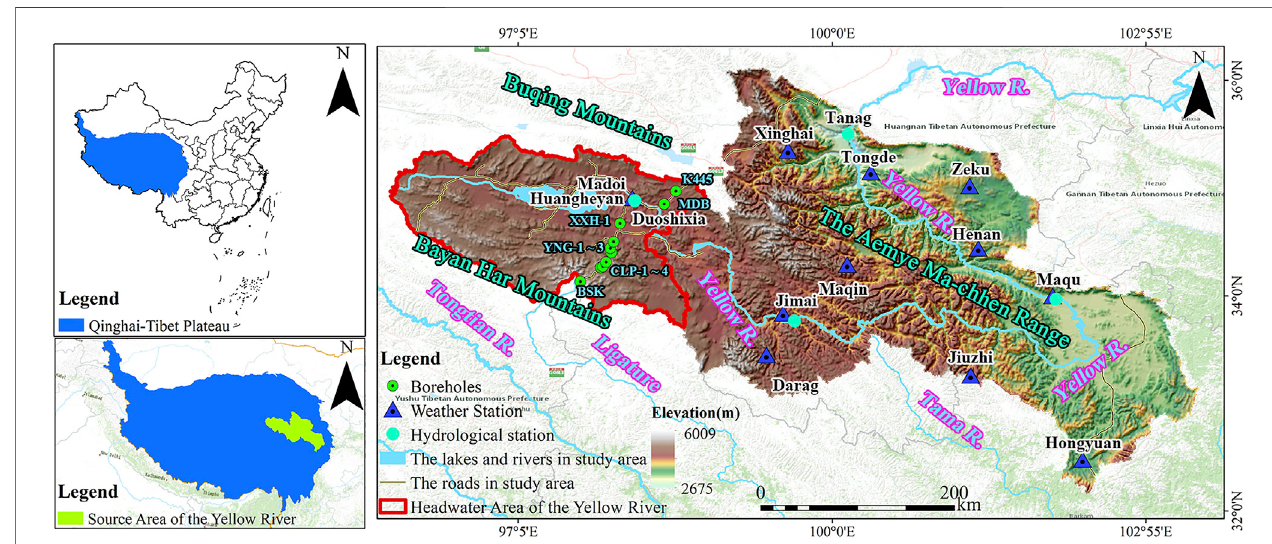
FIGURE 1 | Location, mountains and water systems of the Source Area of the Yellow River on the northeastern Qinghai-Tibet Plateau in Southwest China.